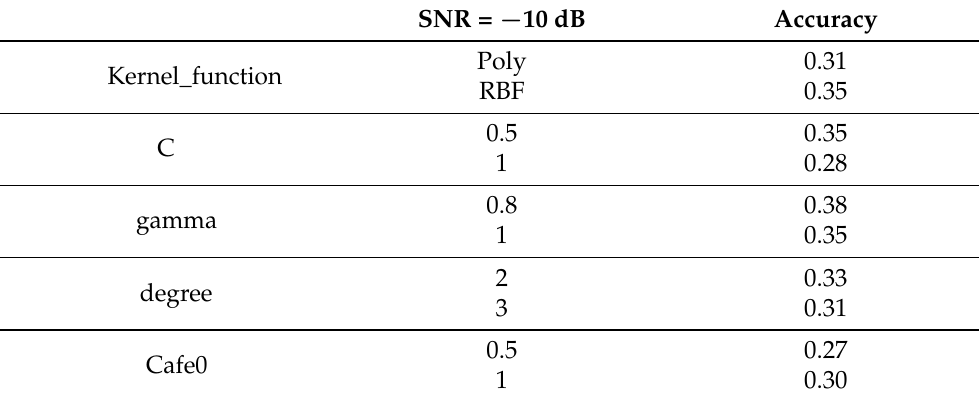
Table 4. The accuracy of SVM model parameters and related functions.